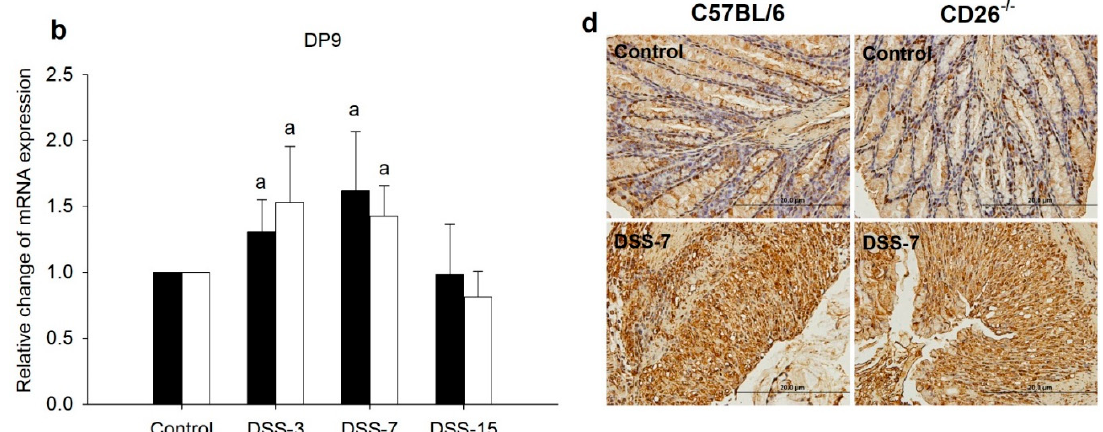
Figure 6. Expression of DP8 and DP9 in colonic tissue of CD26-deficient (CD26 − / − ) mice with dextran sulfate sodium (DSS)-induced colitis. Relative mRNA expression of DP8 ( a ) and DP9 ( b ) in colonic tissue of C57BL/6 and CD26 − / − mice treated with DSS was assessed by quantitative real-time (RT)-PCR. Representative images of immunohistochemical analysis of DP8 ( c ) and DP9 ( d ) protein expressions in colonic tissue of DSS-treated C57BL/6 and CD26 − / − mice in the acute phase of colitis (day 7). Original magnification x400. Scale bar: 20 μ m. The RT-PCR assay was performed in duplicate. Data are presented as mean ± SD. n = 6 mice/each group. a: p < 0.05 compared with control group.